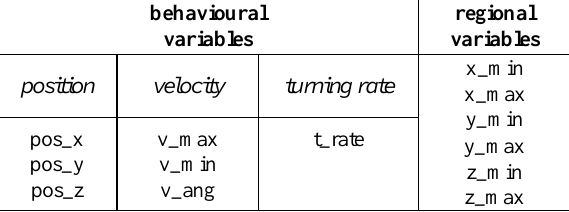
Table 1. Behavioural and regional variables used to model virtual agents’ movement in